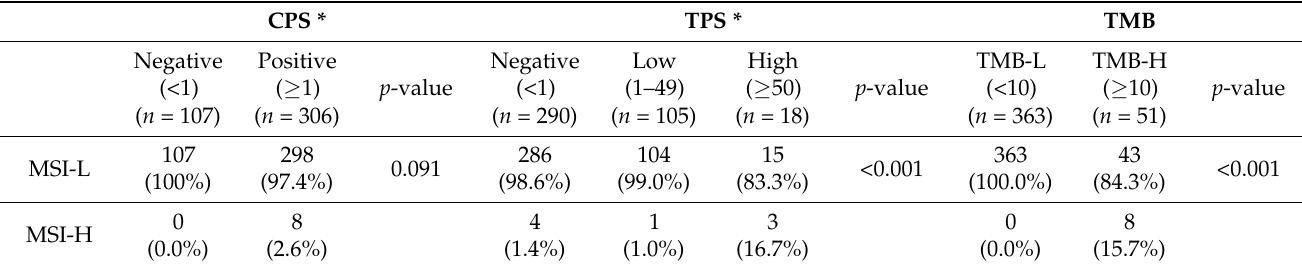
Table 4. Correlation of PD-L1 CPS, PD-L1 TPS, and TMB with MSI status in entire cases. CPS * TPS *